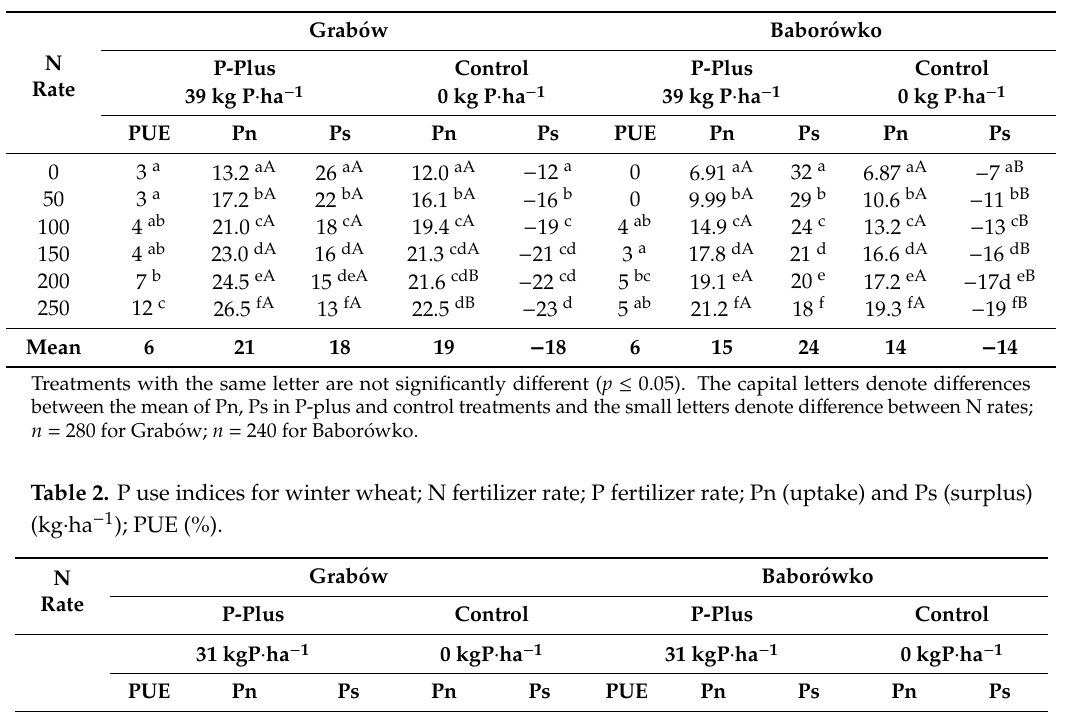
Table 1. P use indices for winter oilseed rape; N fertilizer rate; P fertilizer rate; Pn (uptake) and Ps (surplus) (kg · ha − 1 ); P use e ffi ciency (PUE) (%). Grab ó w Babor ó wko N